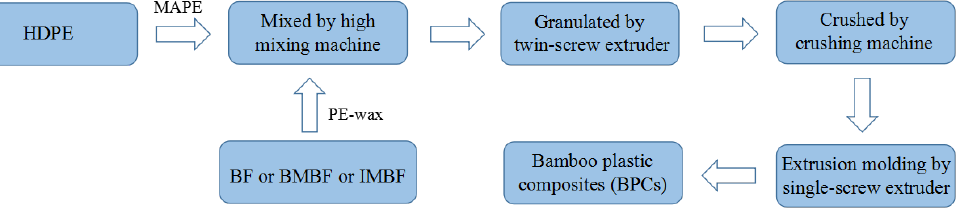
Figure 1. The process flowchart of extrusion molding.